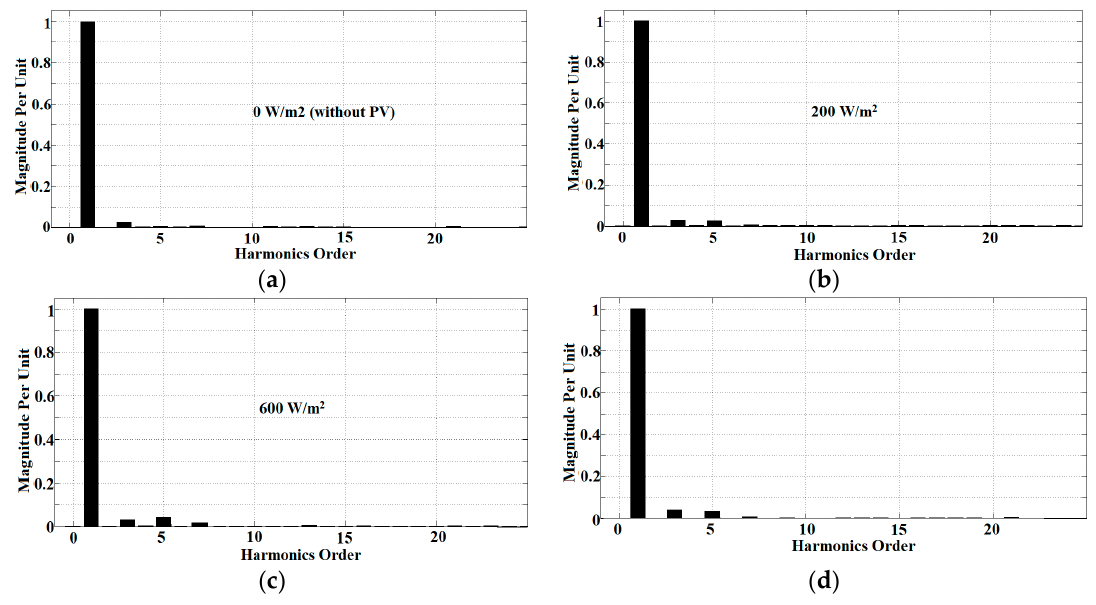
Figure 17. Experimental results of harmonics spectra for inductive load using the Modified W-H ADALINE algorithm at ( a ) 0 W/m 2 (without PV), ( b ) 200 W/m 2 , ( c ) 600 W/m 2 , and ( d ) 1000 W/m 2 .